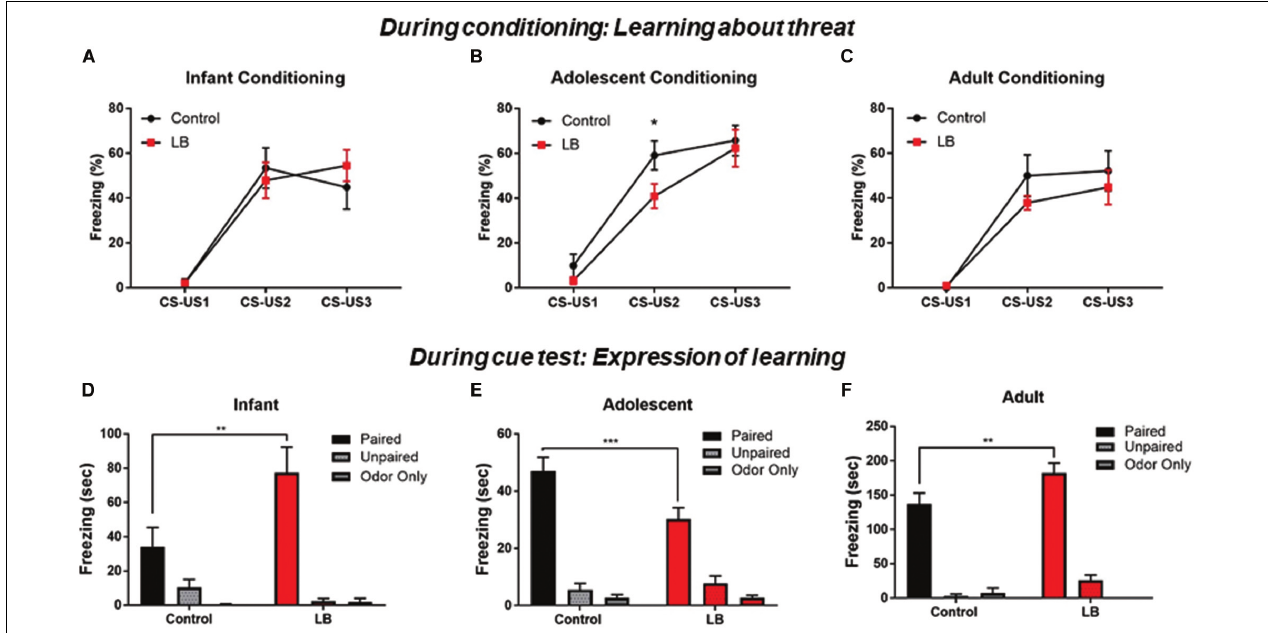
FIGURE 3 | Acquisition and expression of learned threat across development. During conditioning, responses to the CS increased over consecutive CS-US pairings, a pattern indicative of learning. No statistical difference was seen between LB and control rearing as suggested by rate of learning for infants and adults (A,C) , although maltreated adolescents showed some retardation of learning (B) . Cue testing 24 h later in a novel environment was analyzed for percent time spent freezing to the CS at the three ages. All paired animals (control and LB) were significantly higher than unpaired and odor-only controls, although freezing to cues following maltreatment increased in infancy (D) , decreased in adolescence (E) and increased in adults (F) , relative to control-reared animals. ∗∗ p < 0.01, ∗∗∗ p <